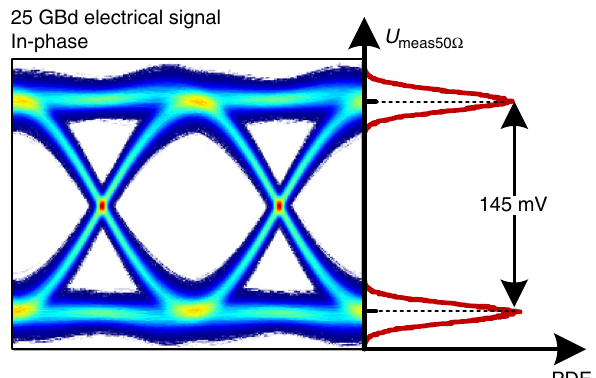
Fig. 4 Measured electrical eye diagram and the probability density function (PDF). The PDF represents the voltage level distribution at the maximum eye opening where the peak-to-peak electrical drive voltage U meas50 Ω ,pp is